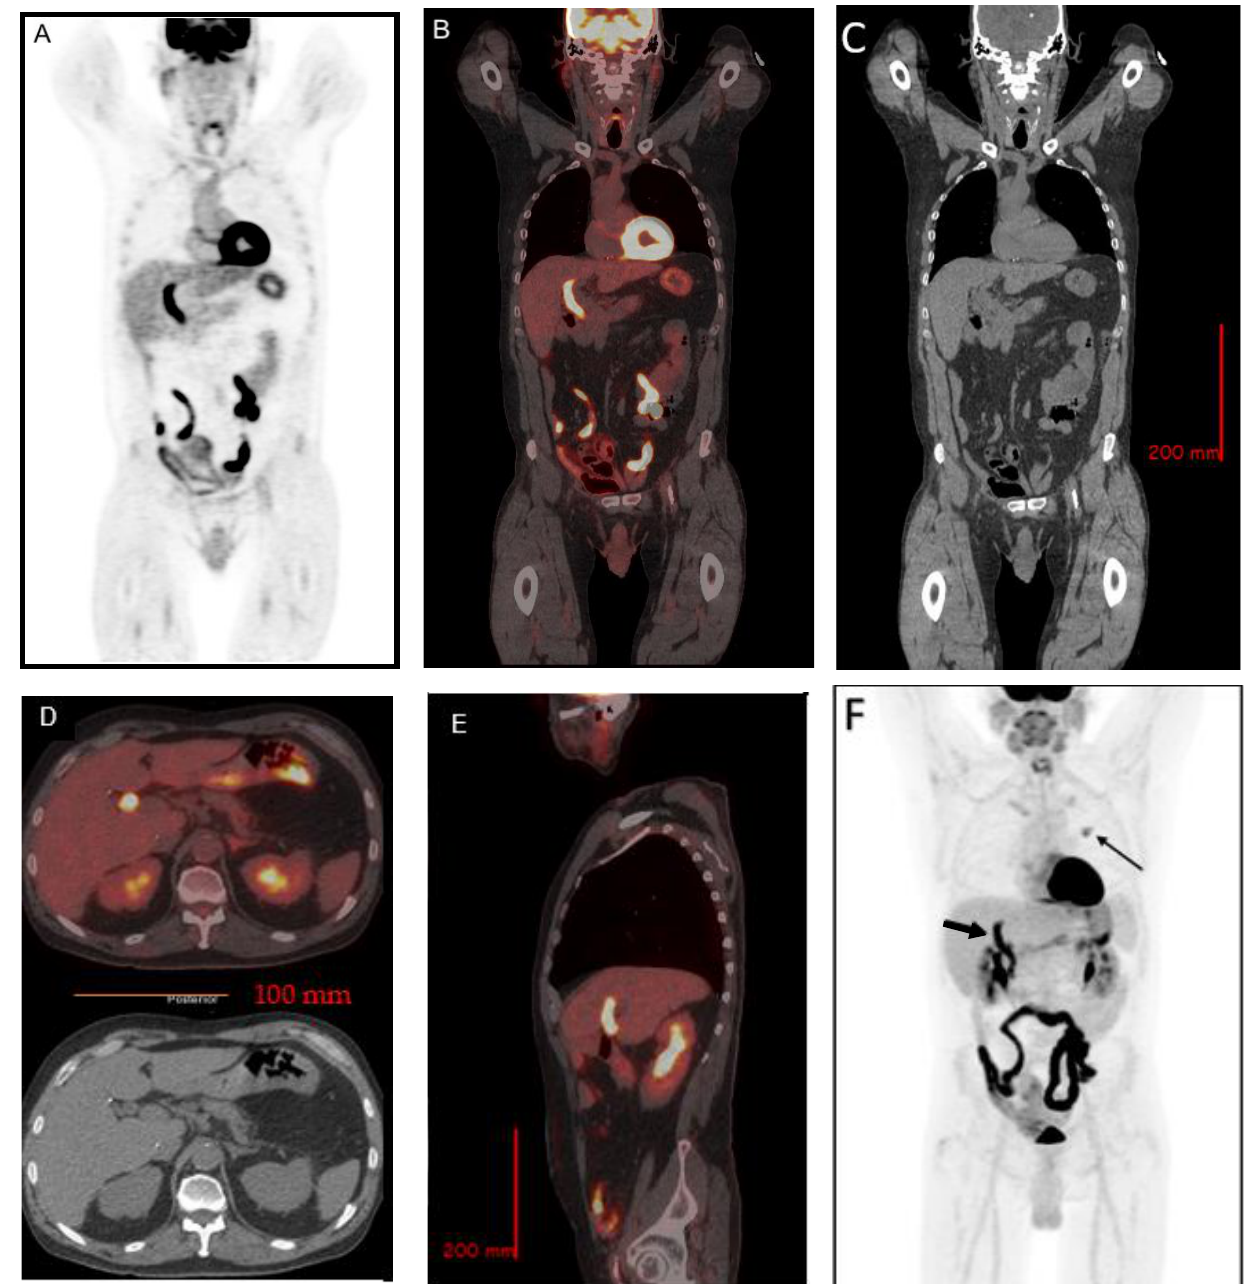
Figure 2. Intense 18 F-FDG uptake (SUV max = 13.3) along the CBD (coronal images, ( A ). PET, ( B ). PET/CT, ( C ). CT, ( D ). Trans-axial images, PET/CT and CT, ( E ). Sagittal images, PET/CT and ( F ). Maximum intensity projection, thought to be due to ERCP-induced inflammation. There is mild fat stranding adjacent to the CBD on the corresponding low-dose CT images without a definite radiopaque stone in the distal CBD. On MIP, intense uptake at common bile duct is noted (short arrow). There is a hypermetabolic lesion in the left lung (long arrow), confirmed to be a metastasis from colon cancer on biopsy. The patient has a remote history of colon cancer 26 years ago, status post-colectomy with ileostomy. Intense uptake in the bowel loops is secondary to metformin use.